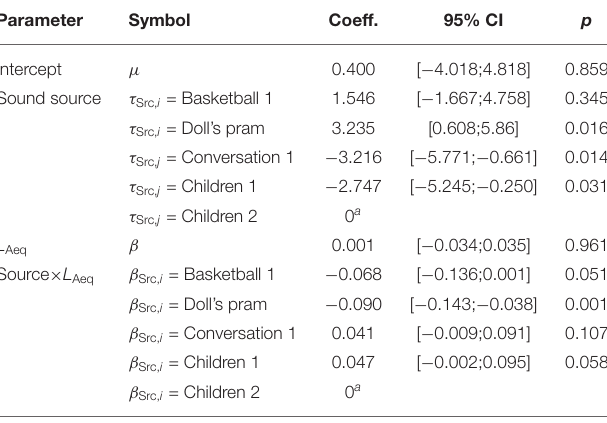
TABLE 4 | Experiment 1: model coefficients (Coeff.), their 95% CI, and probabilities ( p ) of the linear mixed-effects model for acoustic comfort. Parameter Symbol Coeff. 95% CI p Intercept 0.400 0.859 Sound source